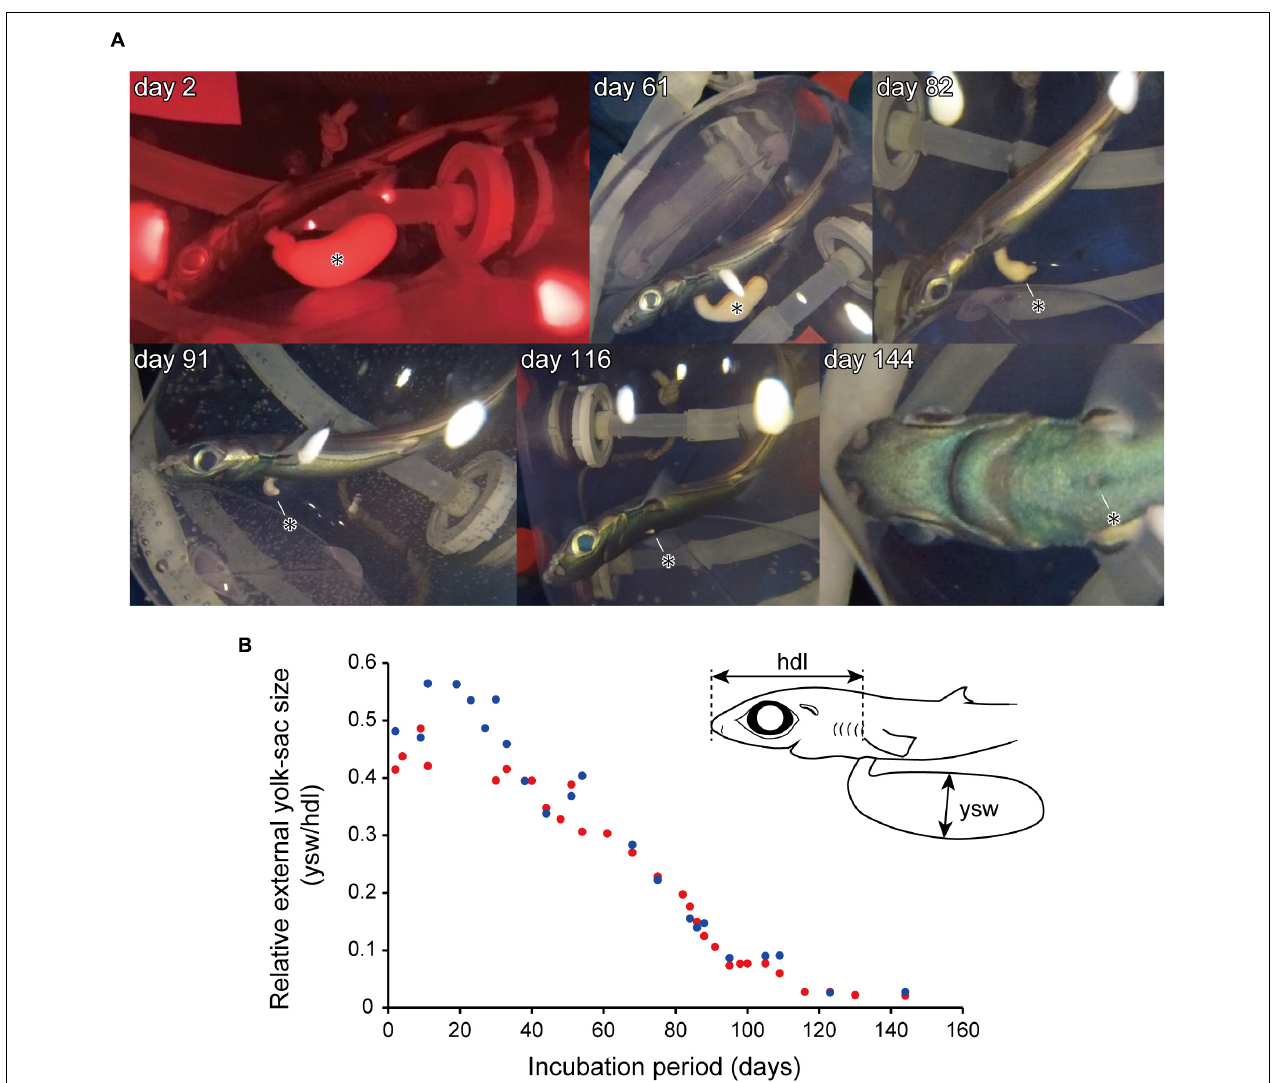
FIGURE 3 | An embryo specimen incubated in the artificial uterus. (A) Temporal changes in embryo external morphology, showing a reduction in the size of the external yolk-sac ( ∗ ). (B) Changes in relative external yolk-sac size in specimen 1 (red) and specimen 2 (blue). The upper right-hand illustration in (B) represents the anterior half of the body of a lantern shark embryo, showing the locations of measurements used for calculating relative external yolk-sac size. hdl, head length; ysw, external yolk-sac